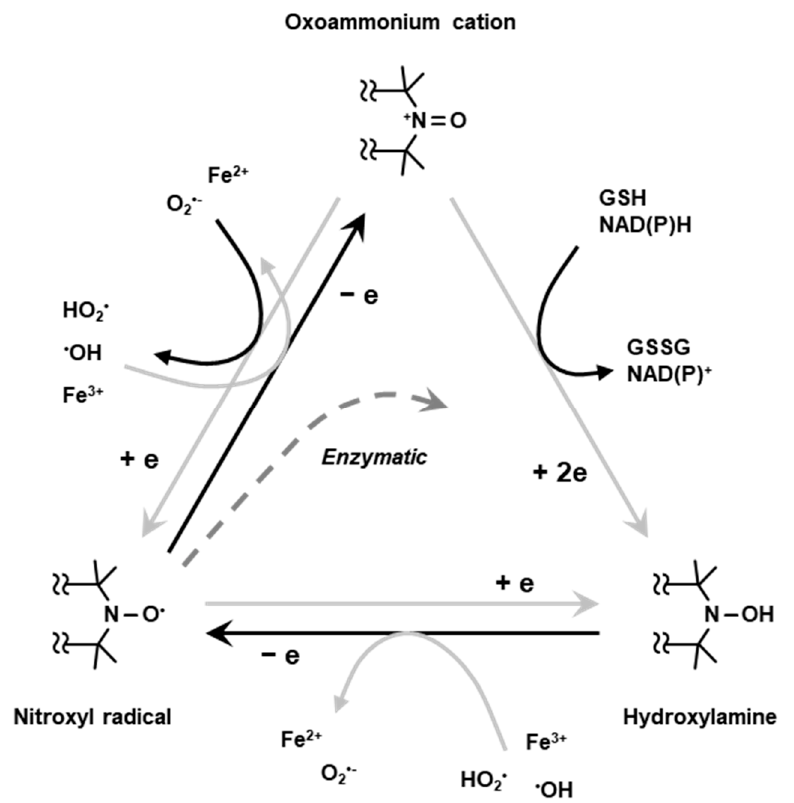
Figure 5. Redox cycling of nitroxyl radical. Nitroxyl radical loses one-electron chemically or enzy- matically in living organisms forming corresponding oxoammonium cation. The oxoammonium cation undergoes two-electron reduction by receiving hydrogen atom from hydrogen donors, such as NAD(P)H and/or GSH, forming the corresponding hydroxylamine. The oxoammonium cation can be reduced back to be nitroxyl radical form. The hydroxylamine can lose one-electron to form nitroxyl radical